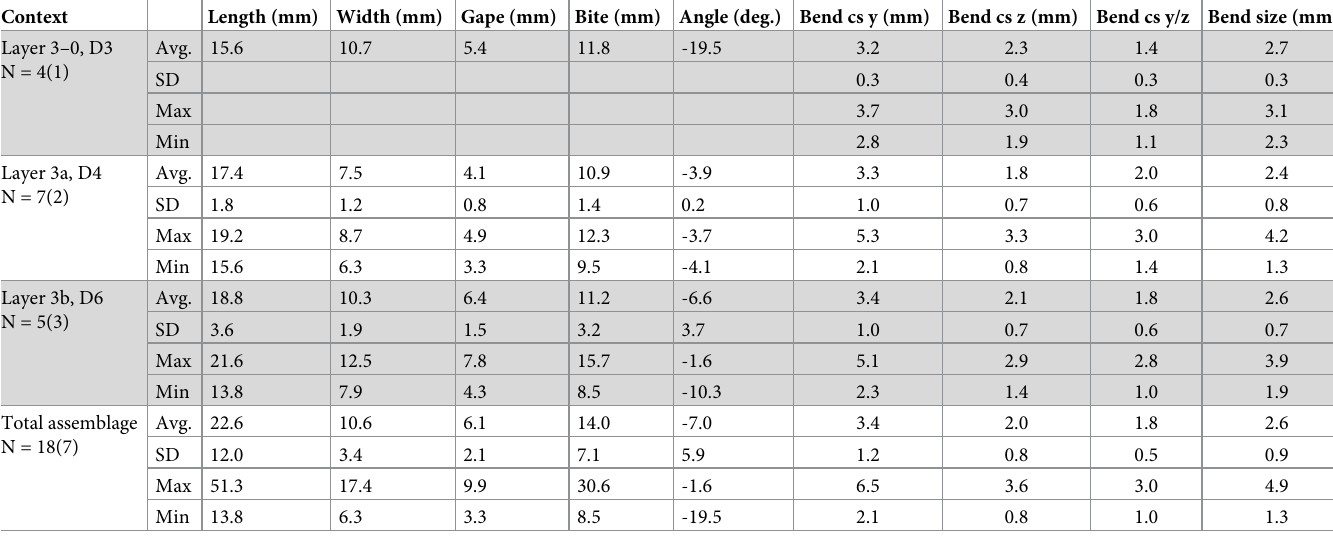
ffiffiffiffiffiffiffiffiffiffiffiffiffiffi p HS ¼ L � W Gape ( G ; mm): distance on the x-axis between the highest vertex of the point and the shank. Bite ( B ; mm): distance on the y-axis between the highest vertex of the point and the lowest vertex of the profile. Measured on all complete and refitted items. Point angle ( PA ; deg.): angle between the point and the shank. The outline of the point and the shank was further subdivided into slices taken along the long axis (100 slices). For each slice, the mean of the length and width coordinates of all the vertexes was calculated. Two straight lines were fitted to best approximate the values of the mean coordinates of all the slices of the point and shank, respectively. The angle between the two fitted lines represents the angle between the point and the shank. Measured on all complete and refitted items. Bend thickness ( T ; mm): distance on the z-axis between the most external vertices of the transversal cross-section of the bend at its lower point. Measured for all items. Bend height ( H ; mm): distance on the x-axis between the lower and the higher vertices of the transversal cross-section of the hook bend at its lower point. Measured for all items. Bend size ( BS ; mm): the square root of the product of bend thickness and height. Measured for all items. ffiffiffiffiffiffiffiffiffiffiffiffiffi p BS ¼ T � H The measurement and the 3D digital models of the hooks are available in “S1 Table”. Hook size results. The JRD hook sample is too small to allow more than descriptive statis- tical analysis. The hooks vary considerably in all size dimensions and ratios (Fig 6, Table 2). Despite this variability, average maximum length of complete hooks declines over time (Fig 4; Table 2). The hooks from Layer 3b are larger on average than the hooks from Layer 3a, while hook #13, the only example from Layer D-8 (equivalent to Layer 3c), is the earliest and the largest of all. A similar trend is observed in the gape and bite dimensions and, although Table 2. Measurements of the JRD bone hooks by layer.